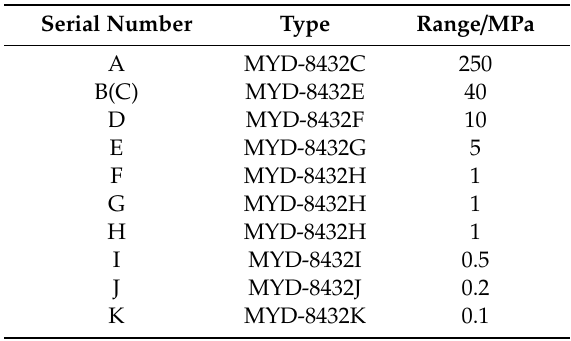
Table 1. The parameters of pressure